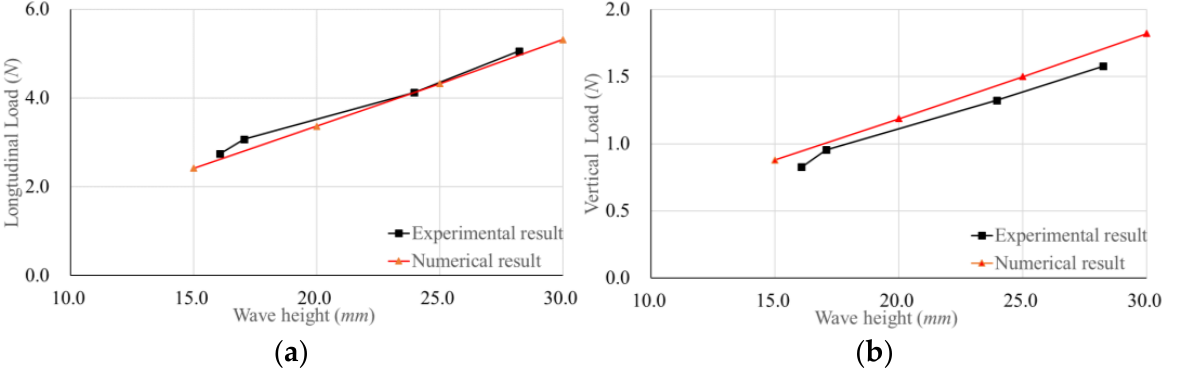
Figure 11. Loads on the hinged connector: ( a ) longitudinal load; ( b ) vertical load.